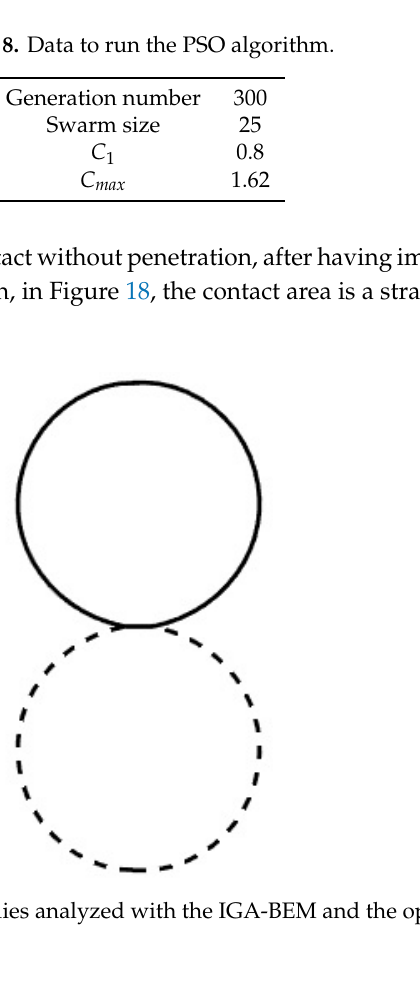
Figure 18. Close-up to the contact area between two bodies analyzed with the IGA-BEM and the optimization proposed.